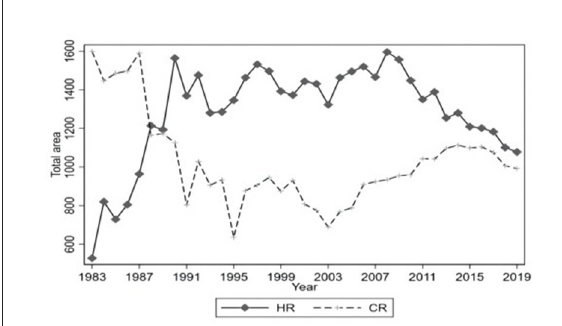
FIGURE1 Cultivation Area of HR and CR in China from 1983 to 2019 (unit: 10,000 ha). Source: Statistical Table of the Popularization of Main Crop Varieties in China, obtained from the China Agricultural Technology Extension Service Center. Notes: The data only includes rice varieties with a cultivation area larger than 100,000 mu (15 mu = 1